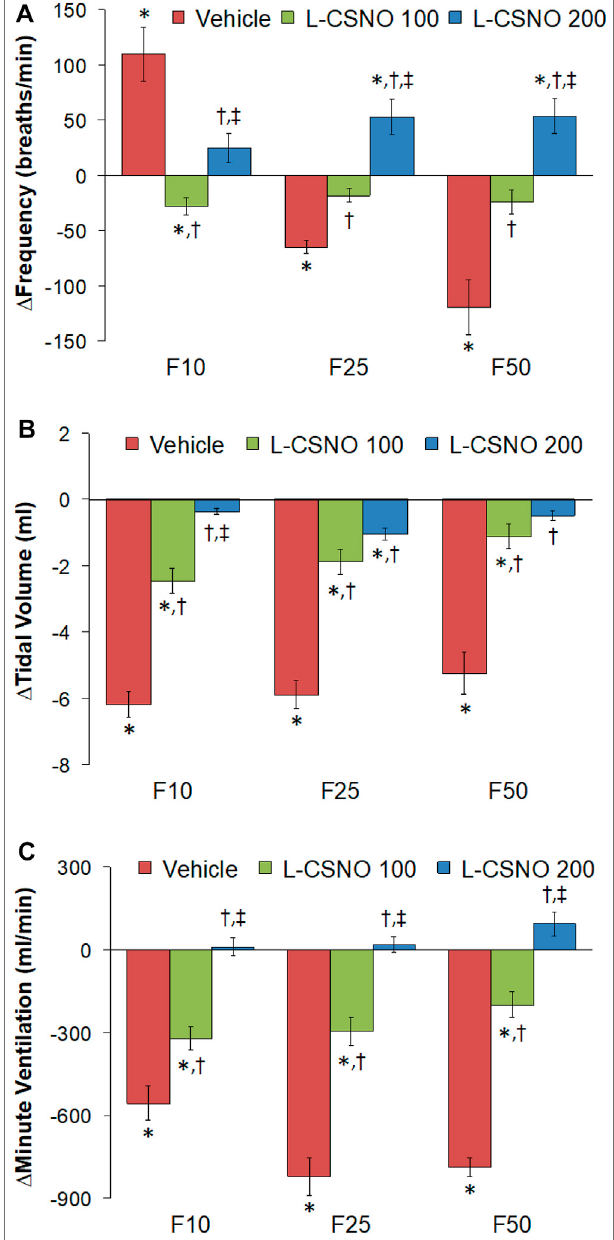
FIGURE 3 | Total arithmetic changes in baseline frequency of breathing (A) , tidal volume (B) , and minute ventilation (C) during the fi rst 5 min following injection of fentanyl at F10 (10 μ g/kg, IV), F25 (25 μ g/kg, IV), and F50 (50 μ g/kg, IV) in rats receiving infusion of vehicle (20 μ l/min, IV),